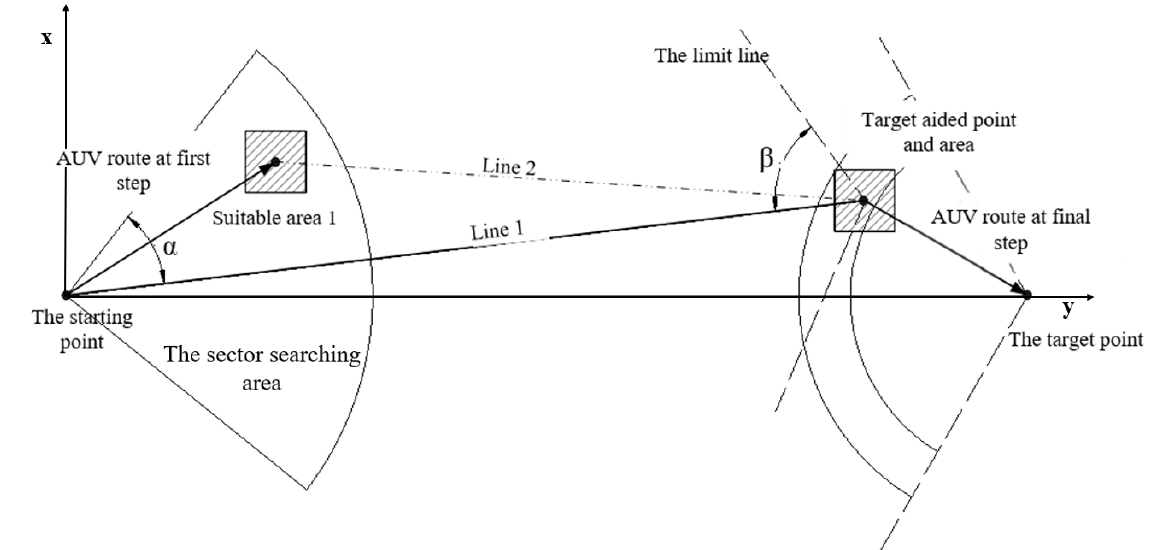
Figure 1. TAN-suitable area searching within a sector.